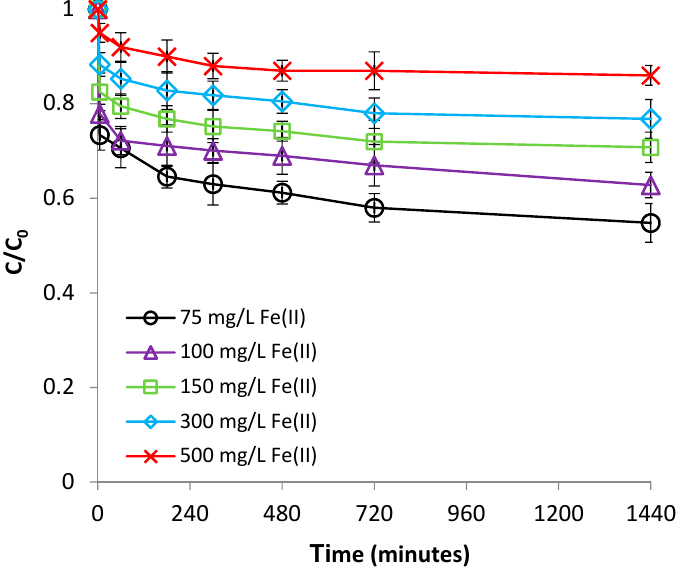
Figure 3. Effect of Fe(II) concentration on Fe(II) removal by bentonite.